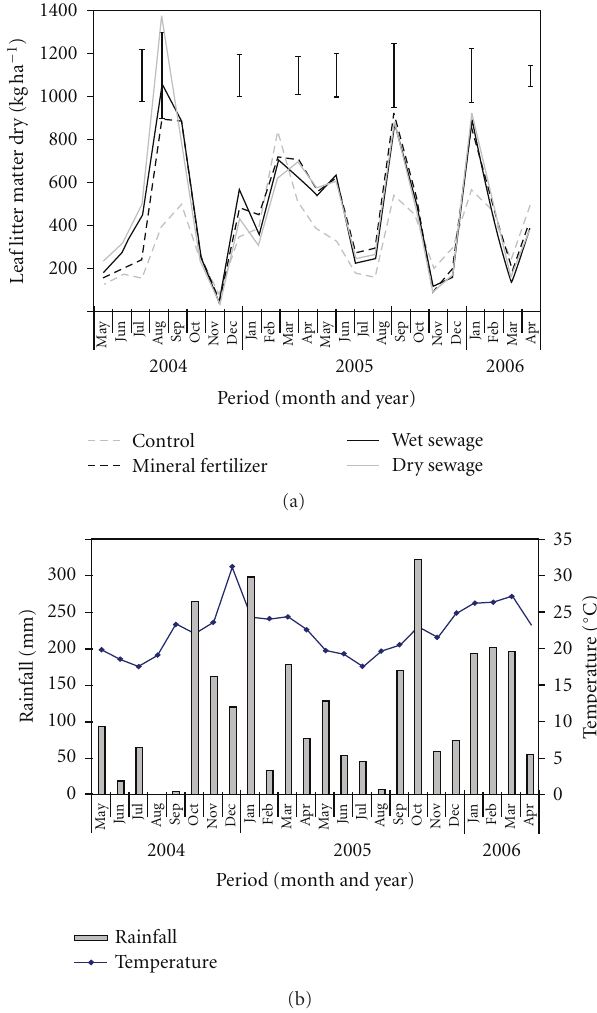
Figure 2: Monthly litterfall production (a), and rainfall and mean temperature (b), from May 2004 to March 2006. Vertical bars indicate least significant di ff erences between treatments ( P < . 05). Di ff erences were not significant when bars are not